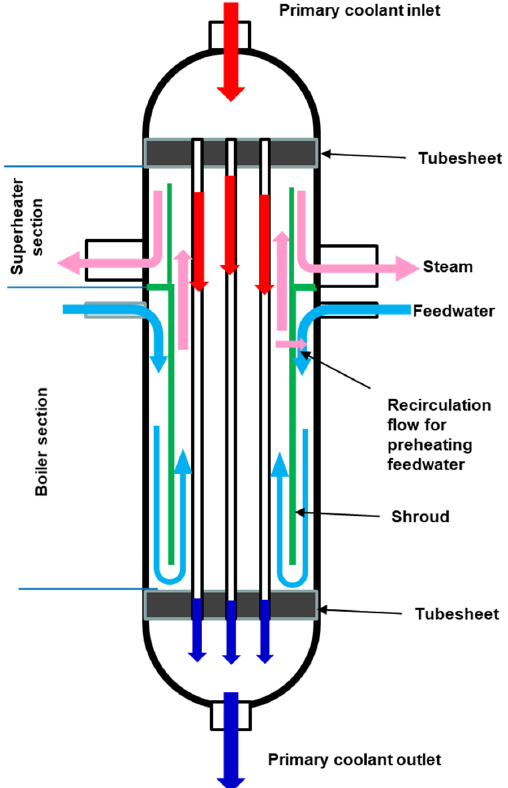
Figure 1. Babcock & Wilcox OTSG concept, scheme taken from [1].